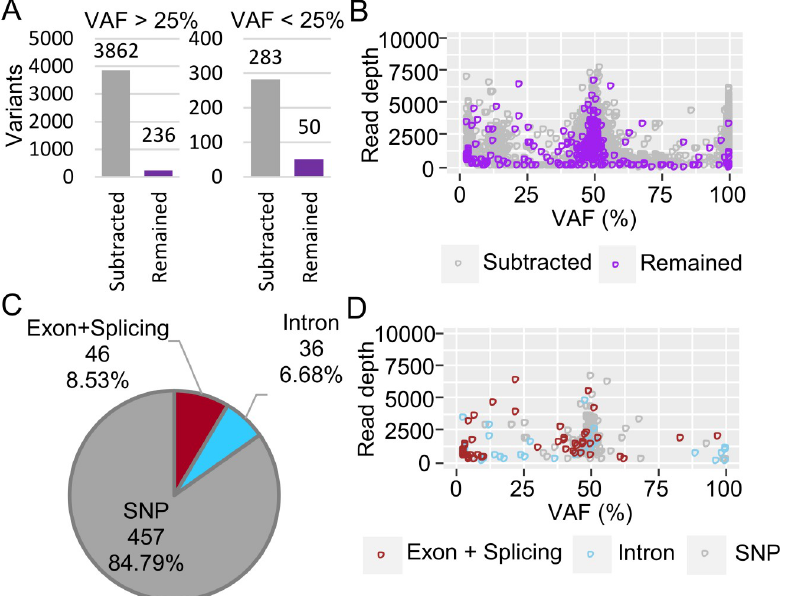
Fig 7. Validation of PON filtration/depth filtration of the variants detected in 21 smear samples using Mutect2. (A) Bar plot of the filtering effect. Variants with a VAF > 25% are shown separately from those with VAF < 25%. The subtracted variants are indicated in gray, and the remaining variants are indicated in purple. (B) Distribution of the subtracted and remaining variants. (C) Pie chart of the filtered variants. Known inherited germline variants (SNP), variants detected in exons and splice sites (exon+splice), and variants detected in introns (intron) are shown. (D) Distribution of the filtered variants.